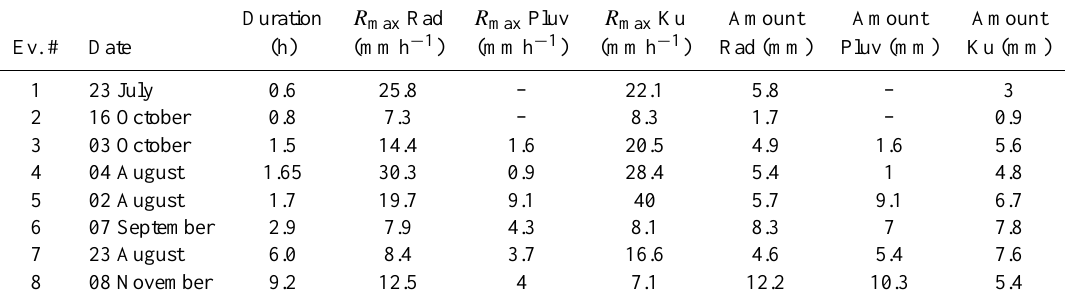
Table 4. Features of the eight selected events. Duration R max Rad R max Pluv R max Ku Amount Amount Amount Ev.